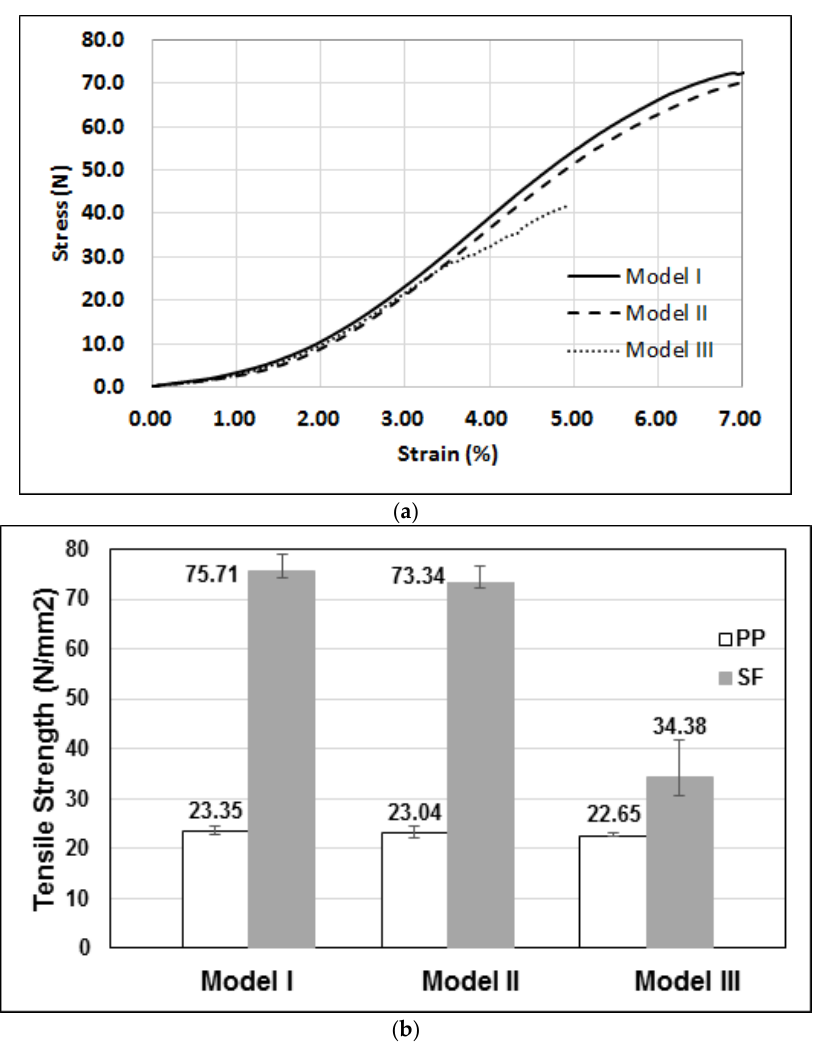
Figure 6. The mechanical properties of the PP-SF material with three different models, ( a ) the stress–strain relation, ( b ) the tensile strength properties. Table 4. The tensile strength (N/mm 2 ) of three models for each test.